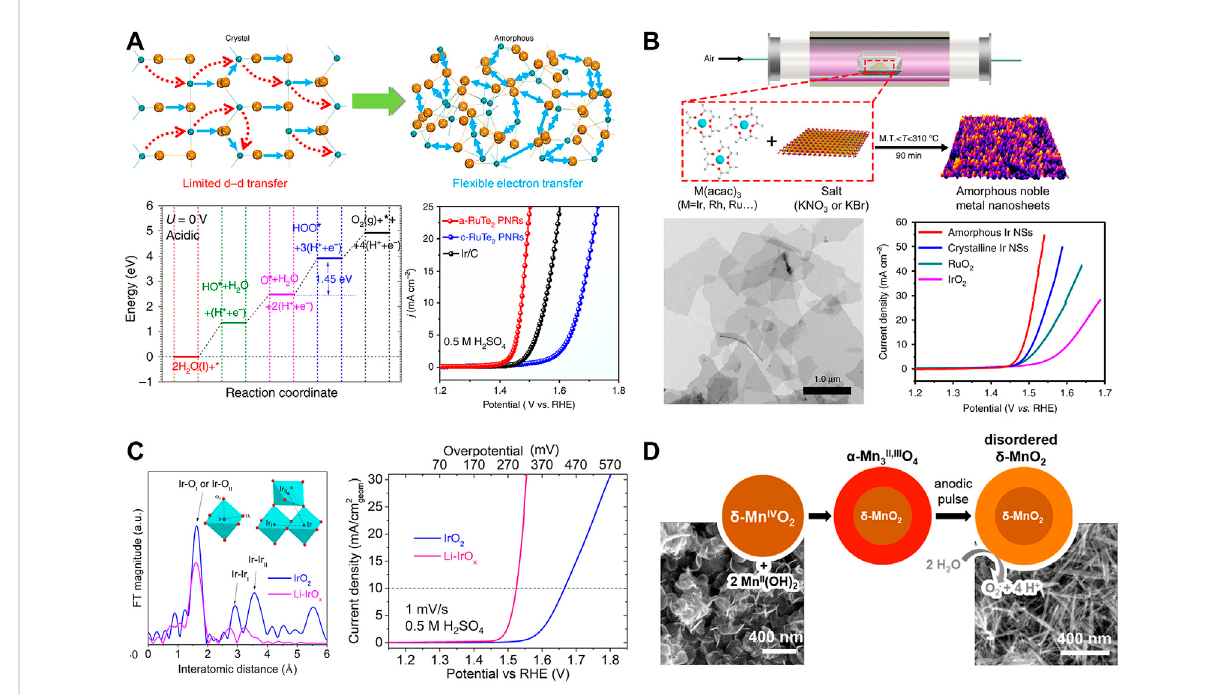
FIGURE 2 (A) Schematicdiagramoftheelectronicactivityenhancement,DFTcalculationforacidicOER,andelectrochemicalcharacterizationofa-RuTe 2 nanorods, reproduced with permission from Wang et al. (2019) (B) Synthesis of amorphous Ir nanosheets, and their structural and electrochemical characterization,reproducedwithpermissionfromWuetal.(2019) (C) Atomiccoordinationmeasurementandelectrocatalyticperformanceofrutile IrO 2 and amorphous Li-IrO x , reproduced with permission from Gao et al. (2019) (D) Structural transition during amorphization of δ -MnO 2 , reproduced with permission from Huynh et al.